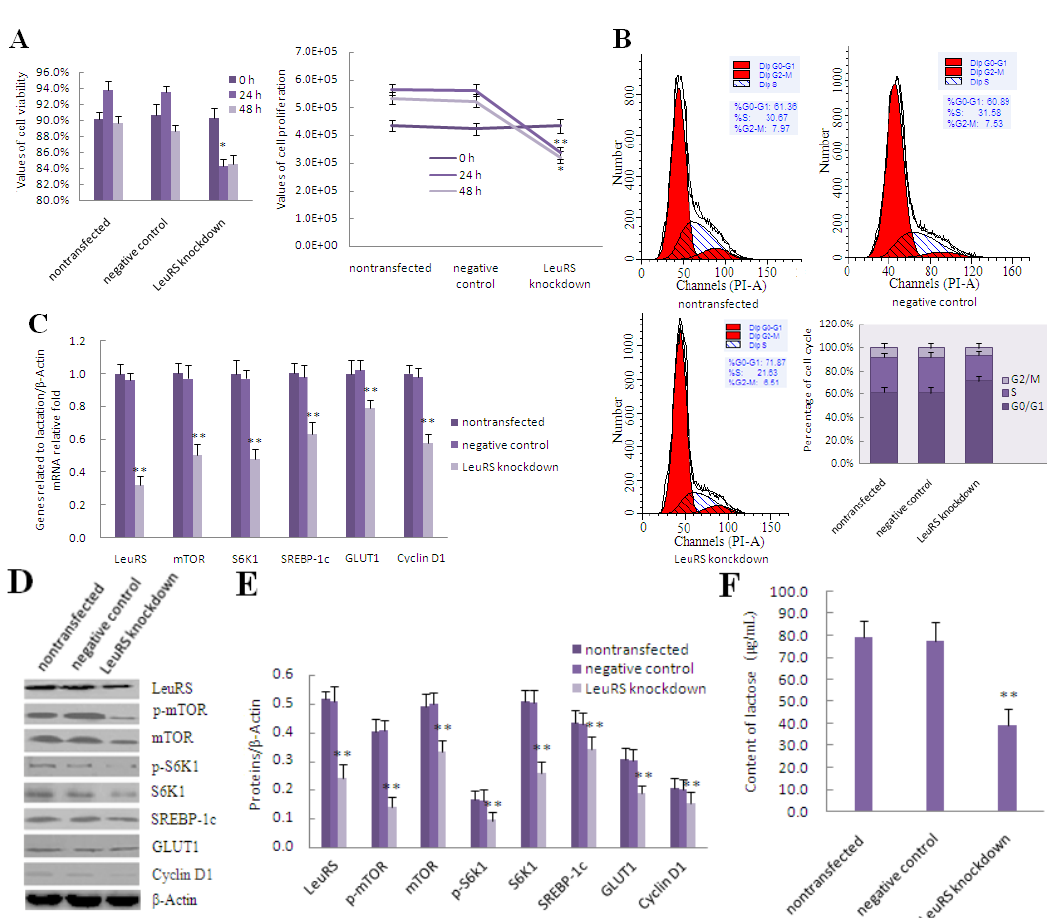
Figure 4. The effect of LeuRS knockdown on leucine-induced proliferation and expression of lactation-associated proteins in DCMECs. DCMECs were divided into three groups: nontransfected group without siRNA and Lipofectamine™ 2000 reagent, control group with a negative siRNA and Lipofectamine™ 2000 reagent as well as transfected group with a LeuRS-specific siRNA and Lipofectamine™ 2000 reagent, all groups were treated with 1.2 mmol/L leucine. ( A ) Cell viability and cell proliferation after LeuRS knockdown for 0, 24 and 48 h were measured by using CASY-TT; ( B ) Measurement of the cell cycle progression by flow cytometric analysis of PI-stained DCMECs after LeuRS knockdown for 24 h; ( C ) Changes in the level of lactation- and mTOR signaling-related gene expression in response to LeuRS knockdown for 24 h as measured by using qRT-PCR; ( D ) Representative western blotting of mentioned proteins. DCMECs were treated as mentioned above for 24 h. β -Actin was assessed as a loading control; ( E ) Quantitation of ( D ); ( F , G ) Lactose and triglyceride secreted into the culture medium were detected after LeuRS knockdown for 48 h; ( H ) β -Casein expression in DCMECs was detected by using qRT-PCR after LeuRS knockdown for 24 h; ( I ) Level of β -Casein protein in DCMECs after LeuRS knockdown for 24 h as assessed by western blotting analysis. β -Actin was assessed as a loading control. A representative blot and quantitation of three independent experiments are shown. In all panels, data represent the mean ± SD of three independent experiments, and three or six wells per treatment within each independent experiment. * and ** indicate p < 0.05 and p < 0.01,